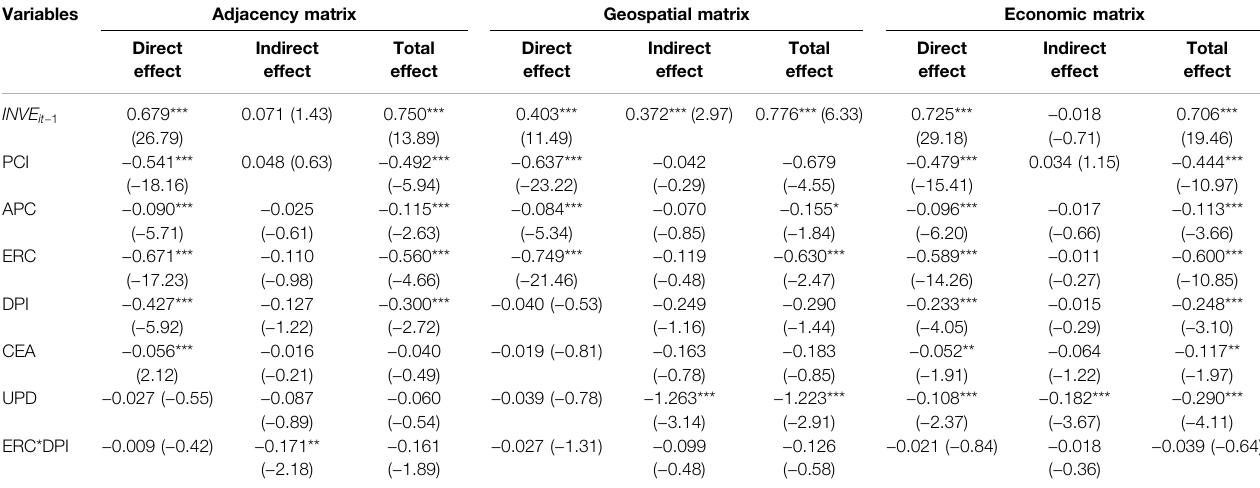
TABLE 5 | Decomposition of the random effects SDM (INVE1).